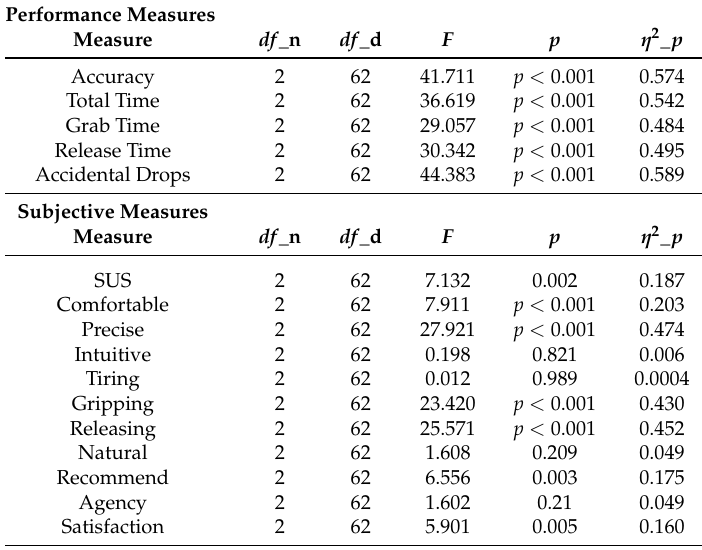
Table 1. Results of one-way repeated-measures ANOVAs comparing performance measures between interfaces (B_Leap, HHI_Leap, Oculus). For post-hoc comparisons, see Table 2. Performance Measures